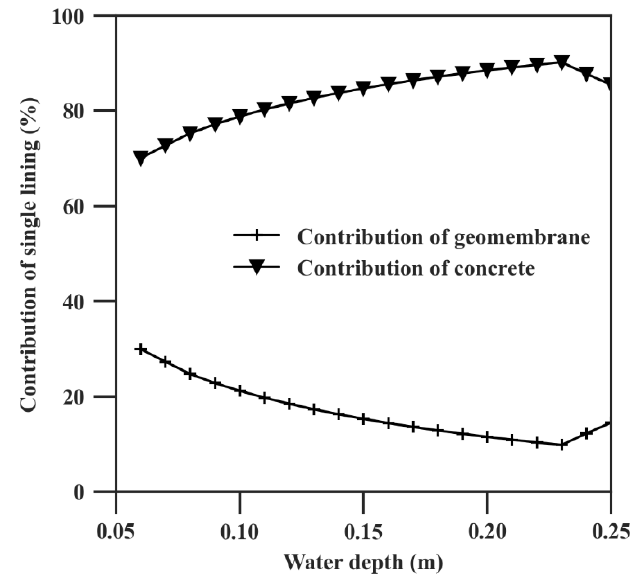
Figure 7. The contribution of concrete and geomembrane with a three year service time in the composite lining.